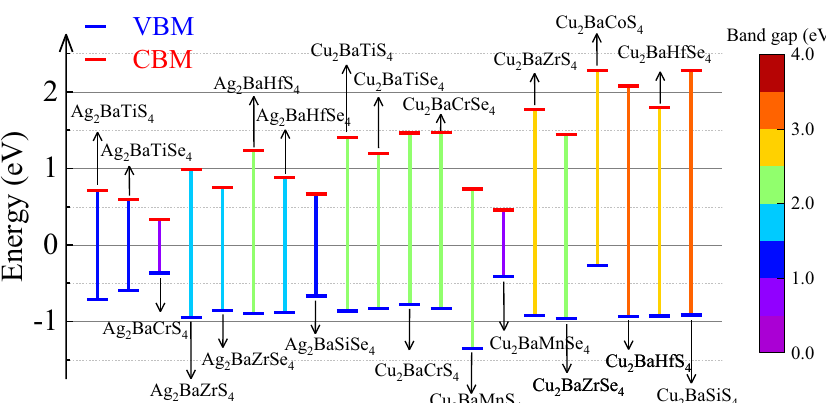
Fig. 4 Edges of VBMs and CBMs for 20 I 2 -II-IV-X 4 semiconductors. The color bar (from purple to red) shows the scale of band